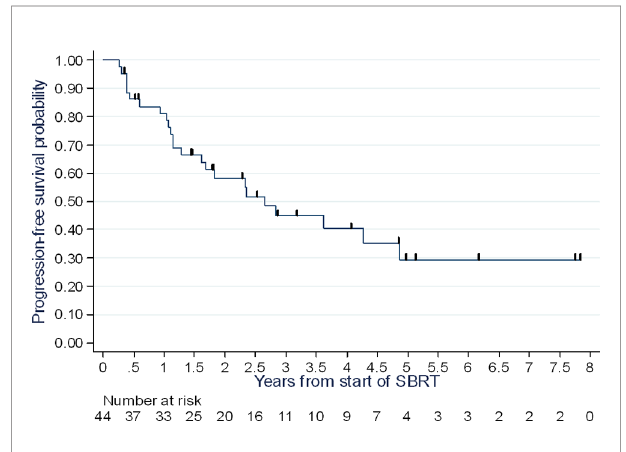
FIGURE 1 | Progression-free survival assessment.